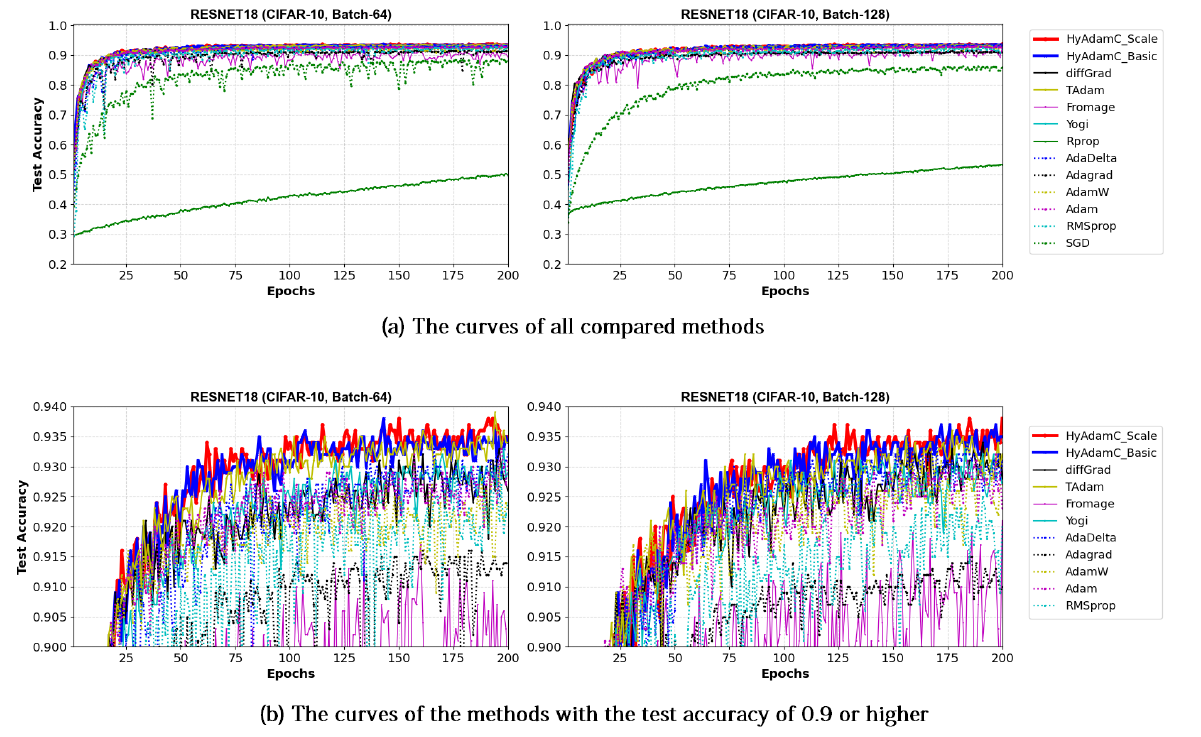
Figure 19. The test accuracy curves of the ResNet-18 trained by HyAdamC and other optimization methods in the CIFAR-10 image classification tasks. In this figure, ( a ) shows the test accuracy curves of all compared methods. On the other hand, ( b ) illustrates the plots in which a range of the y-axis of the plots described in ( a ) is zoomed into between 0.9 and